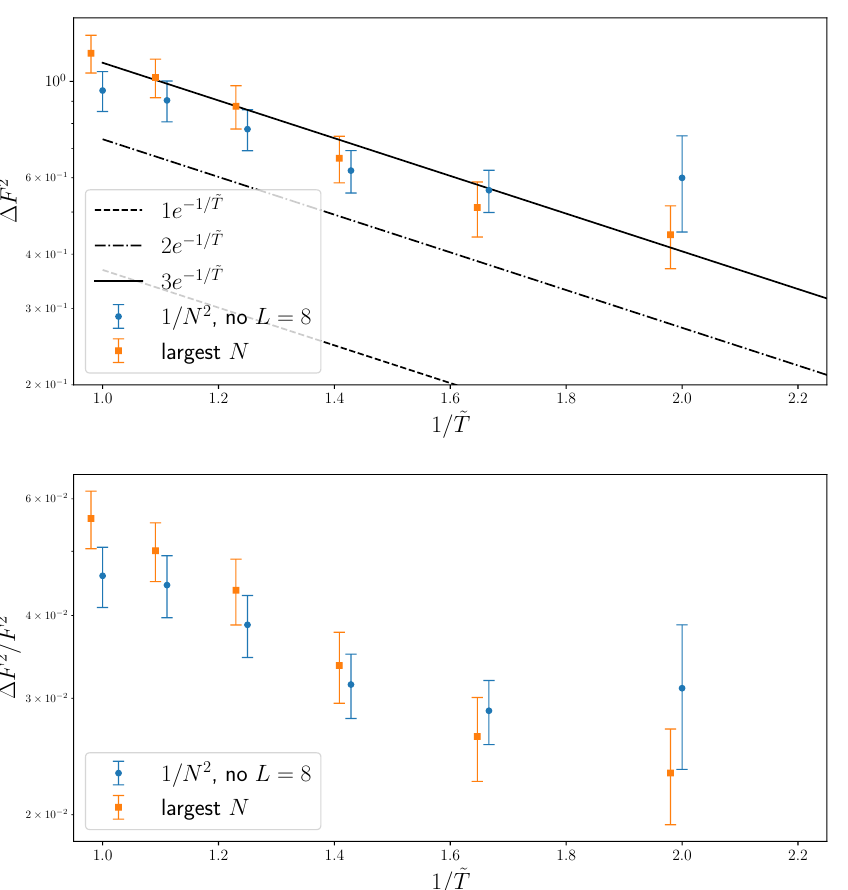
Figure 6. [Upper] (cid:1) ~ F 2 as functions of 1 = ~ T together with some representative functional forms to guide the eye (as done for (cid:1) ~ E ). The datasets shown are in the large- N continuum limit or at our largest N value. [Lower] (cid:1) ~ F 2 = (cid:22) F 2 as functions of 1 = ~ T , where (cid:22) F 2 is the average value between the ungauged and the gauged theory. There is a clear decreasing trend as the temperature